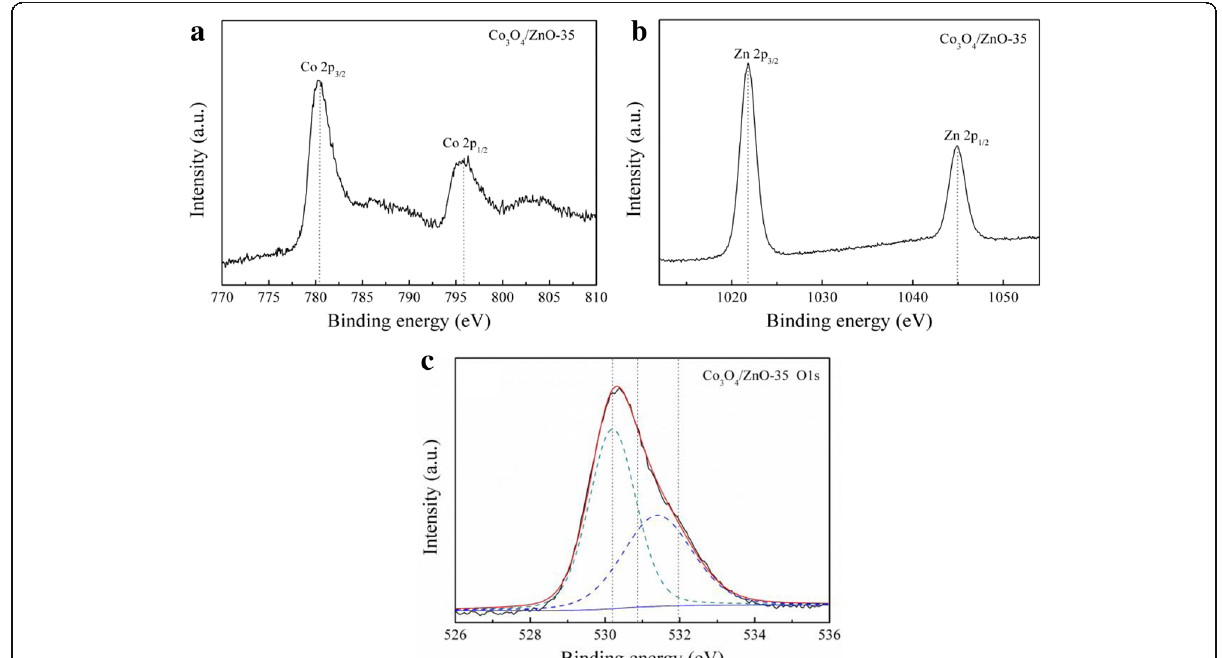
Fig. 9 XPS spectra of a Co 2p, b Zn 2p, and c O 1s of p -Co 3 O 4 / n -ZnO heterostructure